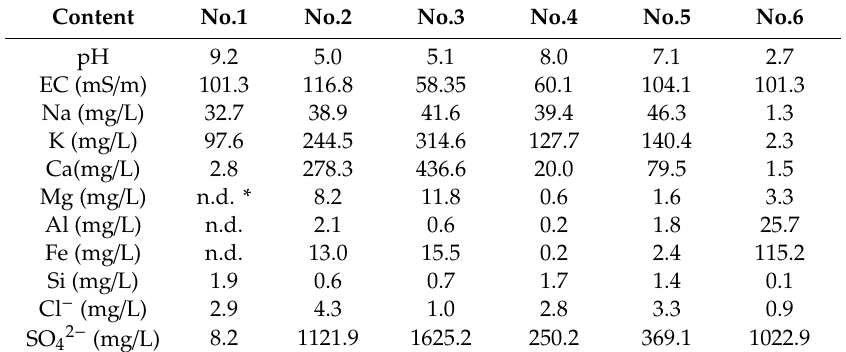
Figure 4. Temporal behavior of the solution electrical conductivity (EC) during the laboratory immersion tests.